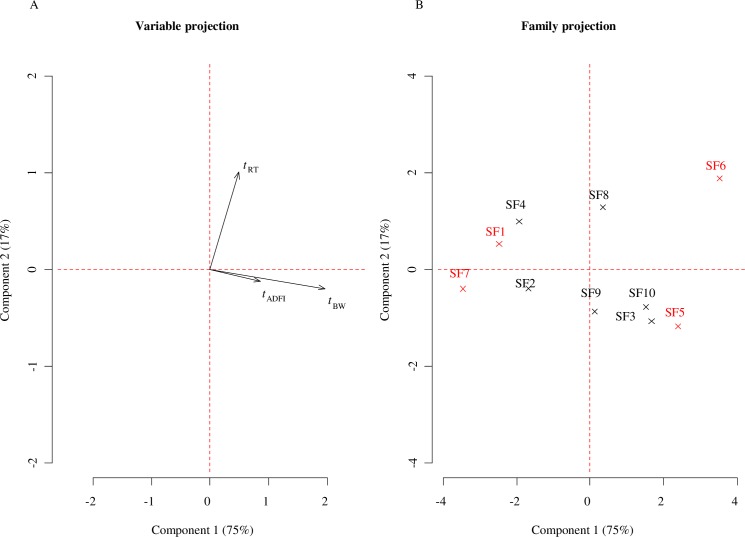
Multivariate description of the sensitivity to heat stress at the sire family (SF) level.PCA was performed on t statistics between TEMP and TROP climates for each SF (tBW, tADFI, tRT for live body weight, average daily feed intake and rectal temperature, respectively). (A) and (B) represent the variables and samples PCA projections on the 2 first component.